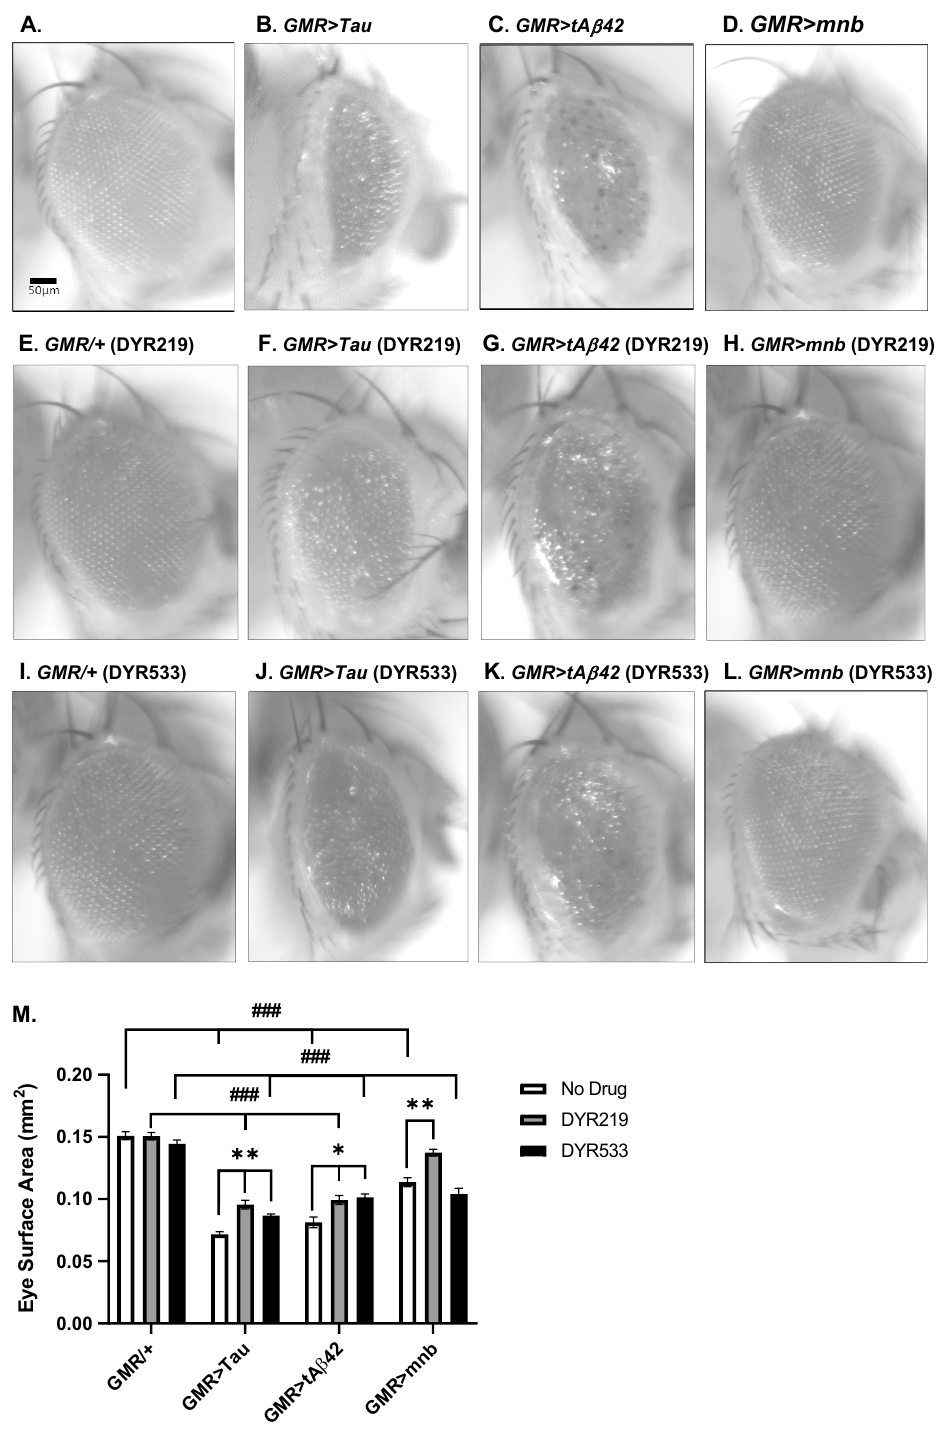
Figure 2. Overexpression of human Tau, amyloid-β42 and mnb in the eye caused degeneration of the photoreceptor neurons suppressed by DYRK1A inhibitors. ( A ) ( Left ) Images of adult fly eyes of control ( GMR-Gal4/ + with scale bar 50 μm) and those overexpressing human Tau 0N4R isoform ( B ), human secreted tandem oligomerising amyloid-β42 ( C ) or (minibrain) mnb isoform H ( D ) throughout development and adulthood. Note the prominent rough eye phenotypes and reduced eye size in flies overexpressing the neurotoxic genes. DYRK1A inhibitors did not affect the eye size of controls ( GMR- Gal4/ +) fed DYR219 ( E ) or DYR533 ( I ). However, DYR219 suppressed the reduction in eye size and rough eye phenotype of the degenerative mutants overexpressing Tau ( F ), tAβ42 ( G ), and mnb (H). Likewise, DYR533 was effective at treating degenerative phenotypes caused by Tau (J), tAβ42 ( K ) but not mnb ( L ). ( M ) Eye degeneration was quantified by eye surface area (n = 7 per genotype and drug treatment group) with flies overexpressing human Tau, human Aβ42 and mnb having smaller eyes than control ( ### P < 0.001, 2-way ANOVA with Dunnett’s post hoc multiple comparisons test). DYR219 increased the size of these smaller eyes ( *P < 0.05 and ** P < 0.01), including completely rescuing the size of the mnb overexpressing eye to a level indistinguishable from control. DYR533 increased the size of the degenerative mutants except